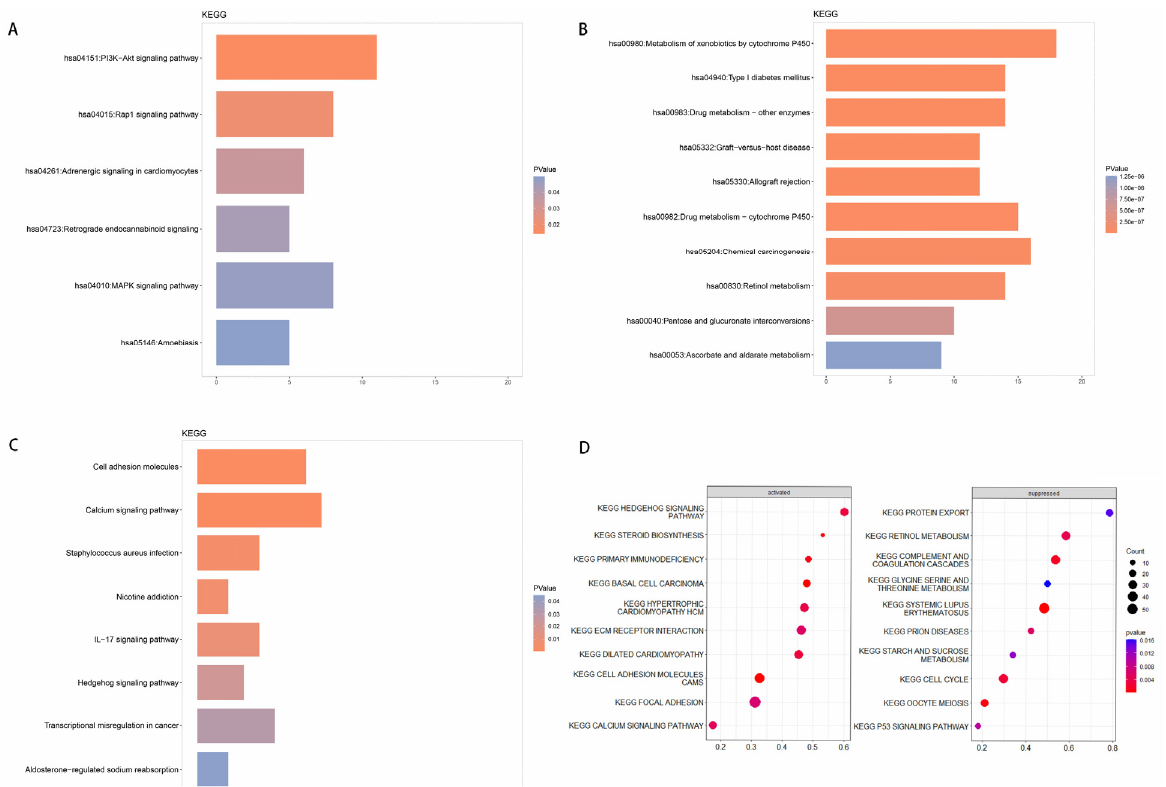
Figure 4. ( A – D ) Enrichment in Kyoto Encyclopedia of Genes and Genomes (KEGG) pathways among genes in carcinoma tissues that were ( A ) upregulated or ( B ) downregulated among patients with moderate-to-severe inflammation and fibrosis relative to patients with mild inflammation and fibrosis. ( C ) Enrichment in KEGG pathways among genes in para-carcinoma tissues in patients with moderate-to-severe inflammation and fibrosis relative to patients with mild inflammation and fibrosis. ( D ) State of activation or inhibition of enriched KEGG pathways.